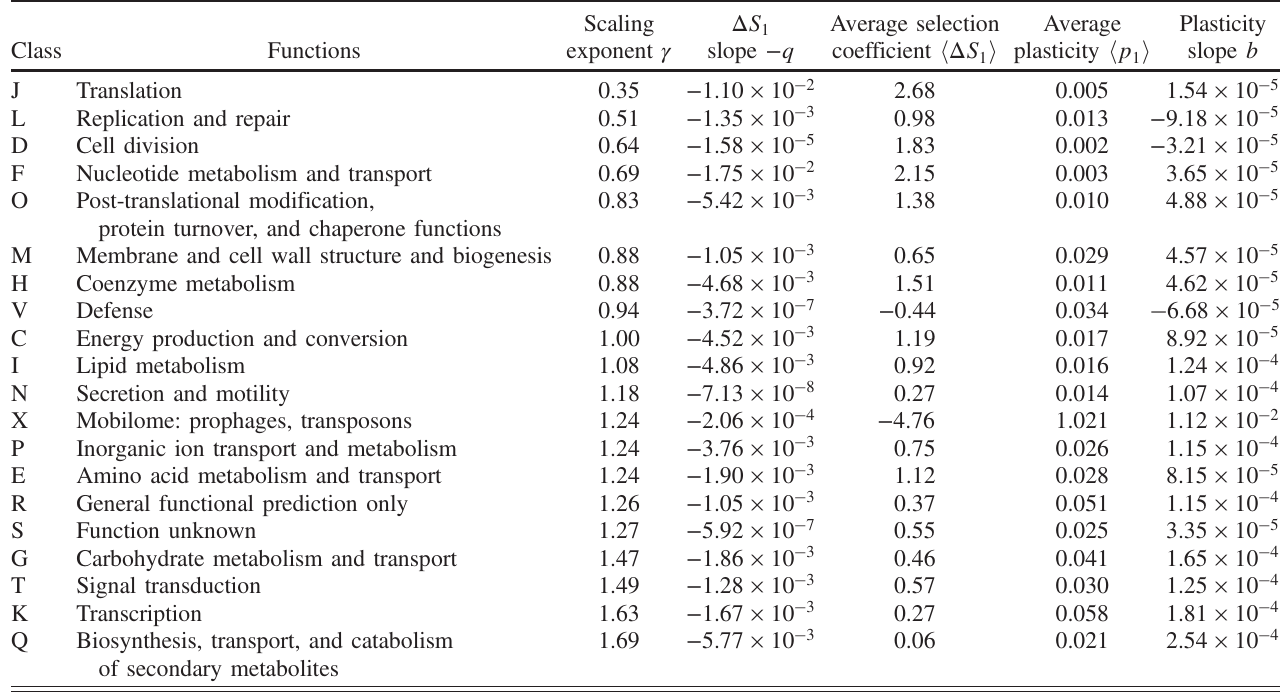
TABLE I. Scaling, selection, and plasticity in different functional classes of microbial